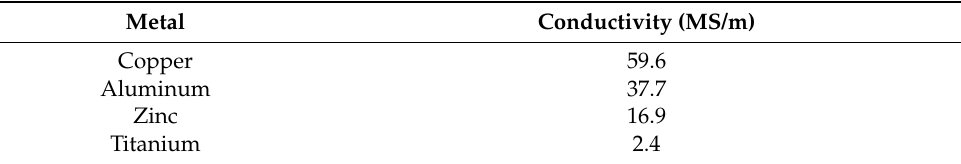
Figure 3. Metals used for the experiment. Table 2. Conductivity of the